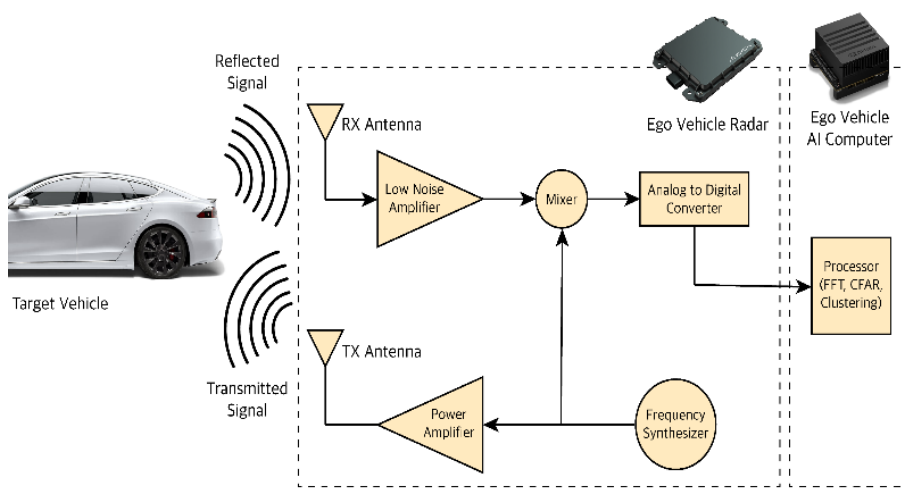
and object detection [54].